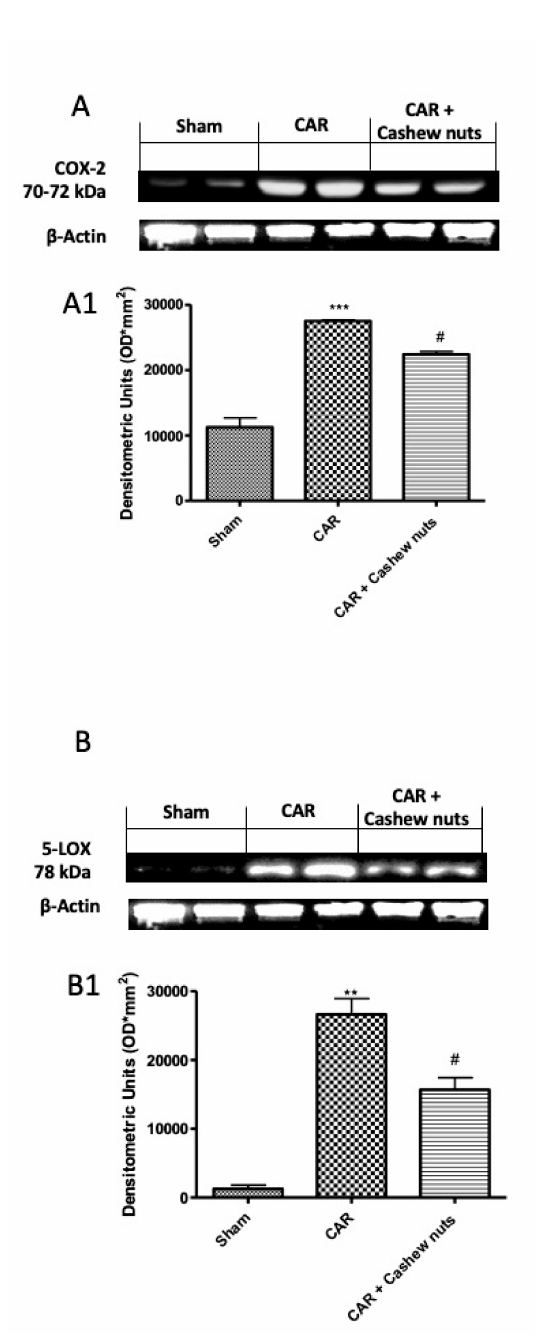
Figure 6. E ff ects of cashew nuts on 5-LOX and Cox-2 expressions. The inhibition of the biosynthesis of inflammatory mediators through the modulation of the activities of 5-LOX and / or Cox-2 considered as a promising approach to treat inflammatory diseases. For these reason we investigated the e ff ect of cashew nuts treatment by Western blots on both enzymes. We found a significant increase after CAR injection, compared to sham, that was significantly decreased in 5-LOX as well as in Cox-2 expression. Representative western blot for Cox-2 ( A ) and LOX-5 ( B ) and respectively densitometric analysis ( A1 , B1 ). See materials and methods for further details. # p < 0.05 vs. CAR; ** p < 0.01 vs.